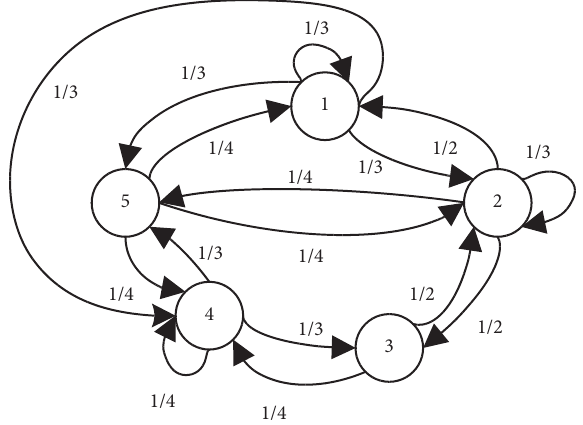
Figure 5: One-step transfer Markov chain. Table 5: Markov chain analysis results of the composite prediction